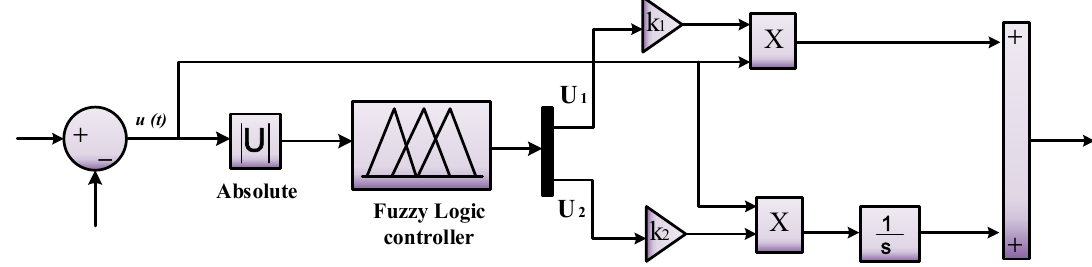
Figure 7. Control structure for error tracking.